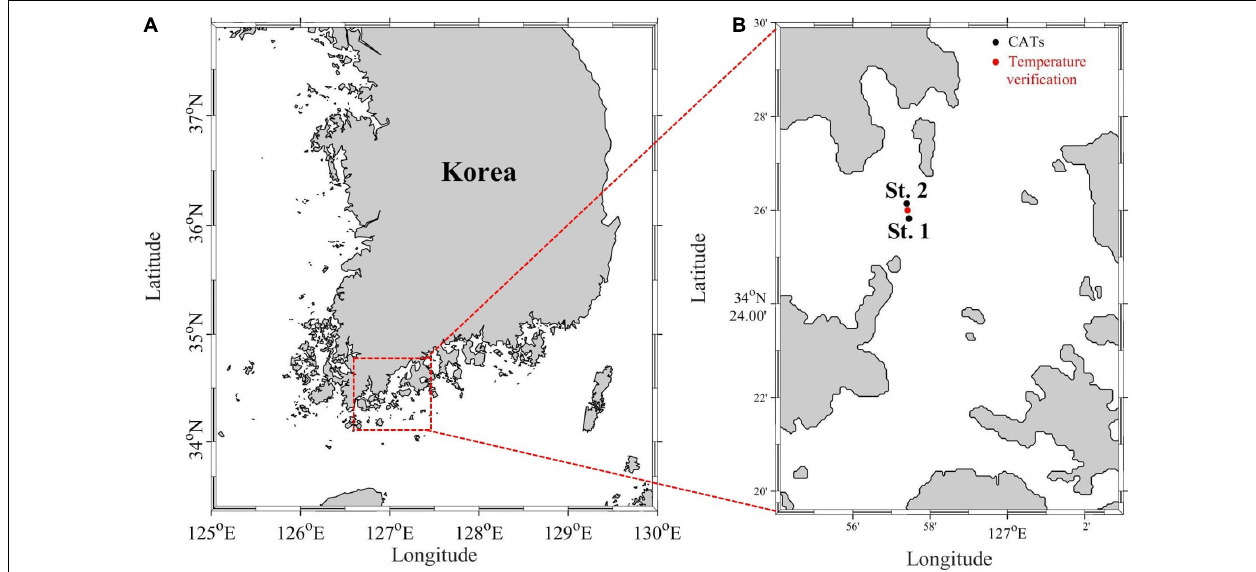
FIGURE 1 | (A) Locations of the two stations used in the CAT field experiment. Station 1 is deeper than Station 2. Temperatures between the estimated and the observed were compared at the location marked by the red dot in (B) .